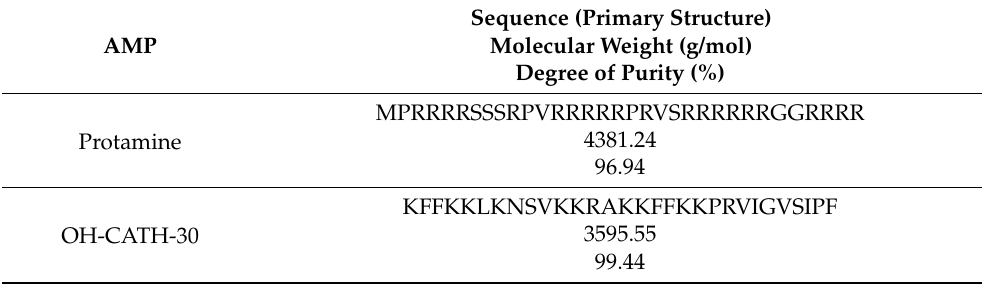
Table 3. Sequence and molecular properties of used antimicrobial peptides